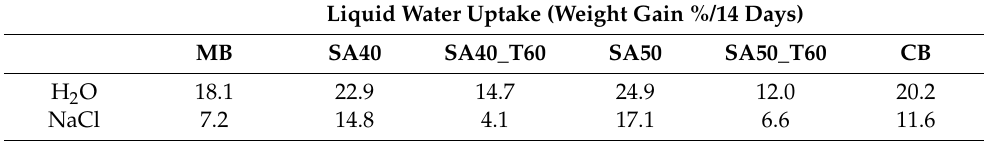
Table 2. Liquid water uptake values after 14 days of immersion in water or 3.5 wt% NaCl solution of the film cast at 23 ◦ C (MB, SA40, SA50 and CB) and at 60 ◦ C (SA40_T60 and